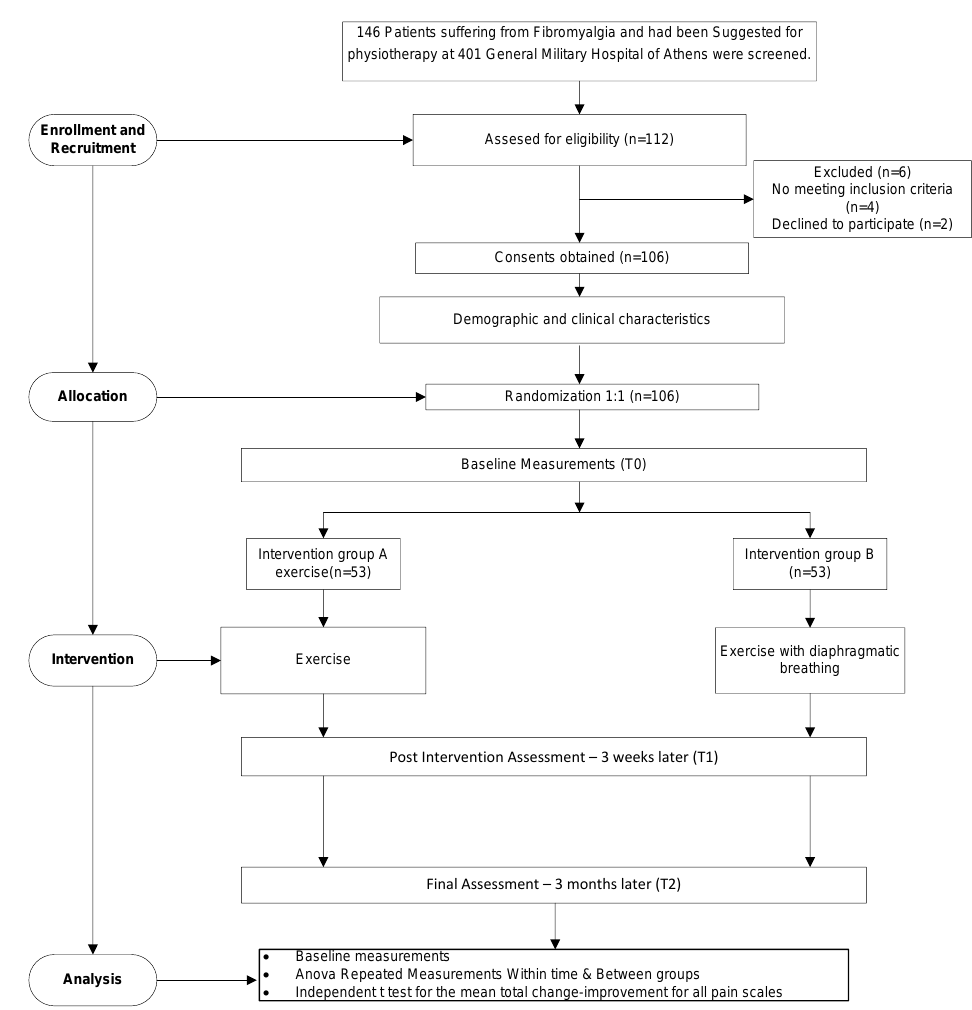
Figure 1. Flow diagram of patient progress through the